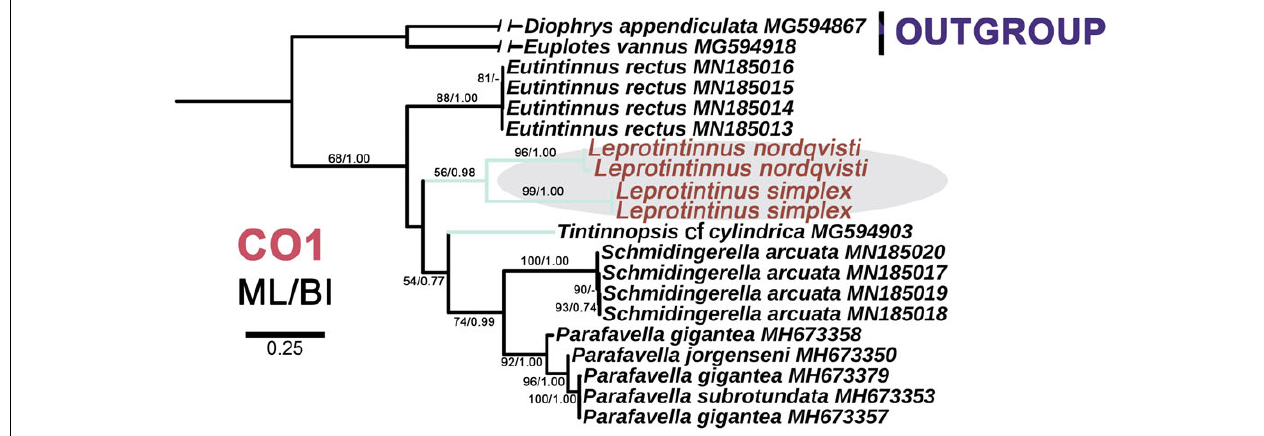
FIGURE 10 | The maximum likelihood (ML) phylogenetic tree is inferred from CO1 gene sequences. Numbers at the nodes represent support values in the following order: ML and BI bootstrap values. The green branch denotes the incertae sedis taxa in Tintinnina. The new sequences Leprotintinnus neriticus and L. simplex in the present work were indicated in red. A hyphen (–) represents support values too low (ML < 45%, BI < 0.70) and disagreements in topology between the BI and ML trees. The scale bar corresponds to 25 substitutions per 100 nucleotides.